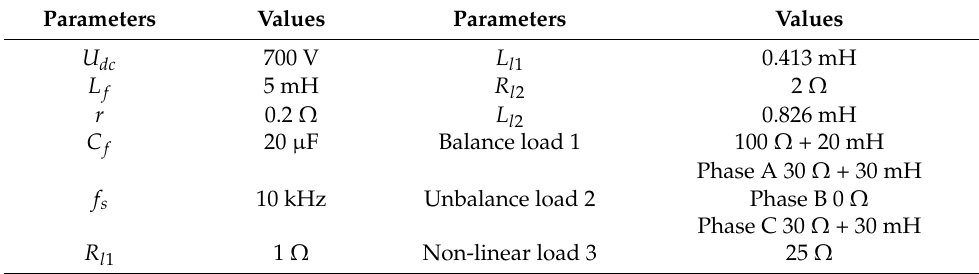
Table 1. Line Parameters of Low Voltage Microgrid.